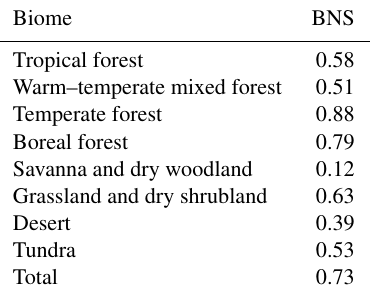
Table 2. Best neighbour score (BNS) showing the agreement be- tween pollen-based reconstructions and the mega-biomes converted from the simulated plant functional type cover fractions. Values be- tween 0.2 and 0.5 mean “fair to good” agreement, above 0.5 “good to very good” agreement and above 0.8 “excellent” agreement. For details on the metric, see Dallmeyer et al.